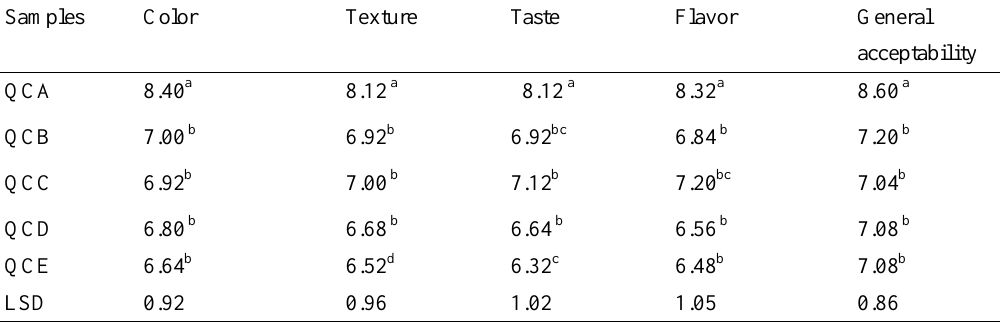
Table 3: Sensory evaluation of Queen Cake